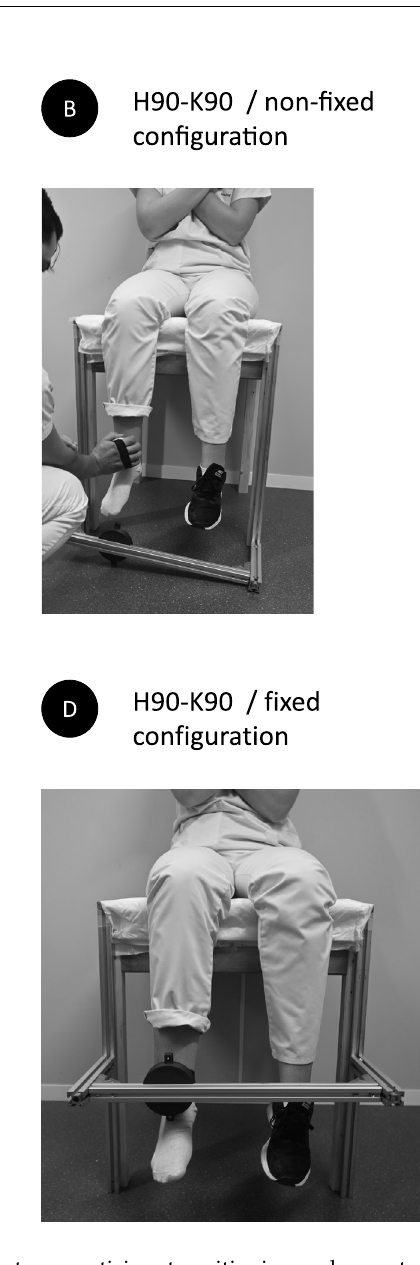
Figure 1. Illustration of the testing structure, participant positioning and operator positioning.